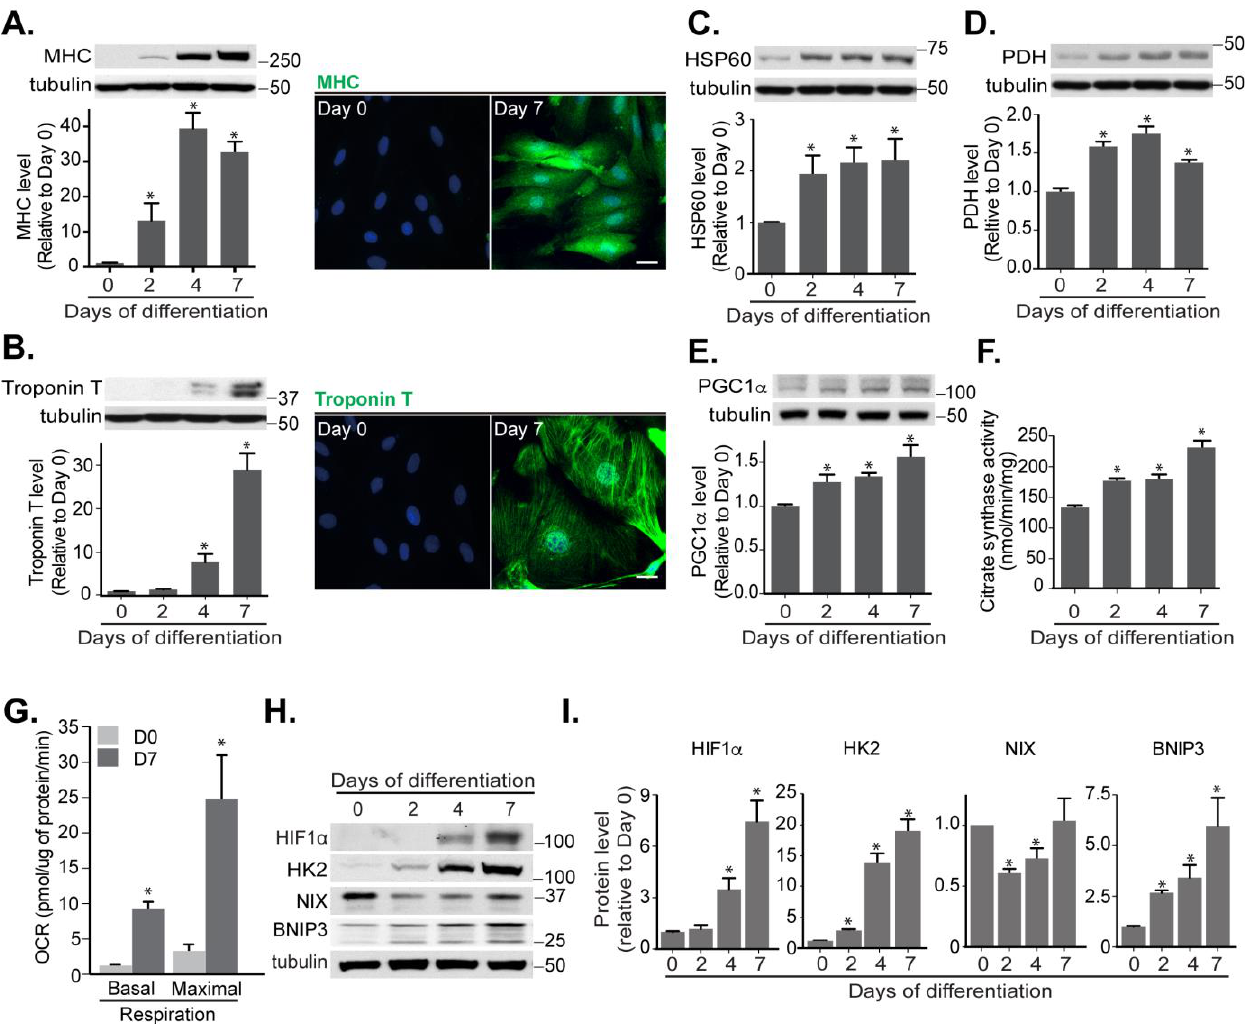
FIGURE 3: Mitochondrial functions increase during cardiomyoblast differentiation. Protein levels and immunofluorescence staining of myosin heavy chain (MHC) (A) and cardiac Troponin T (B) were performed in H9c2 cells following differentiation for 0, 2, 4 and 7 days. HSP60 (C) , PDH (D) , PGC1α (E) protein levels and citrate synthase activity (F) were determined during this period. (G) Oxygen consumption rate (OCR) was measured in H9c2 cells following 7 days differentiation. (H-I) HIF1α, Hexokinase 2 (HK2), NIX and BNIP3 protein levels we re examined and quan- tified in H9c2 cells during the indicated days of differentiation. α -tubulin was used as a loading control. All quantitative data are mean ± SEM from 3 independent experiments. Scale bar, 20 μm. * P <